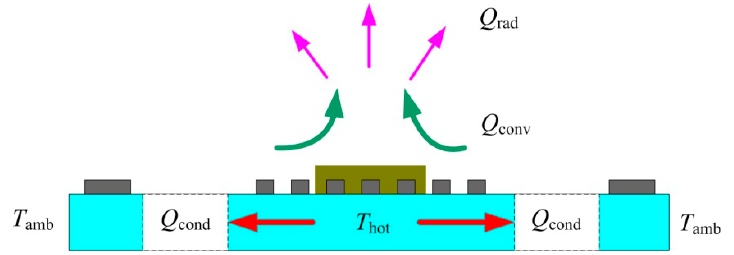
Figure 2. Schematic diagram of the thermal diffusion of ceramic micro hotplate sensor structure.